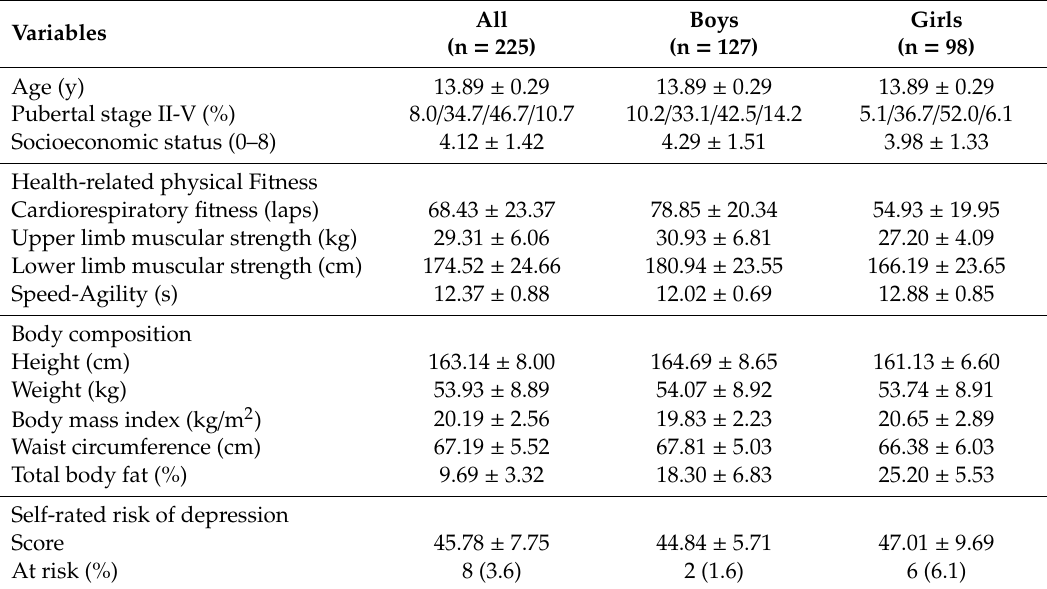
Table 1. Descriptive characteristics of the study sample by